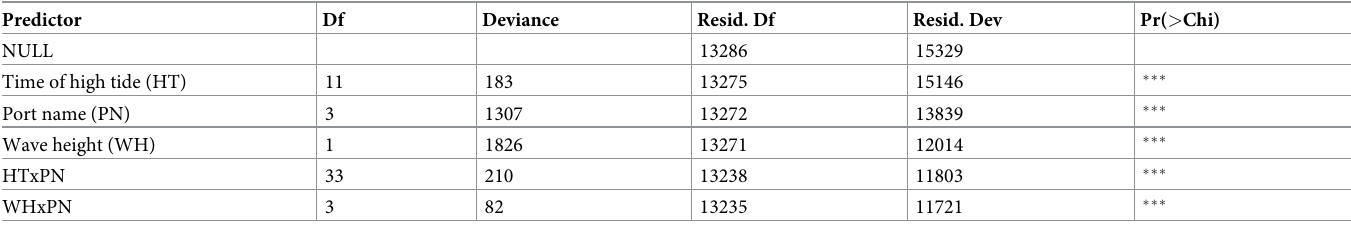
Table 3. Analysis of deviance table for the Leave Port model. The dependent variable was whether or not a vessel left port to go fishing. Predictor Df Deviance